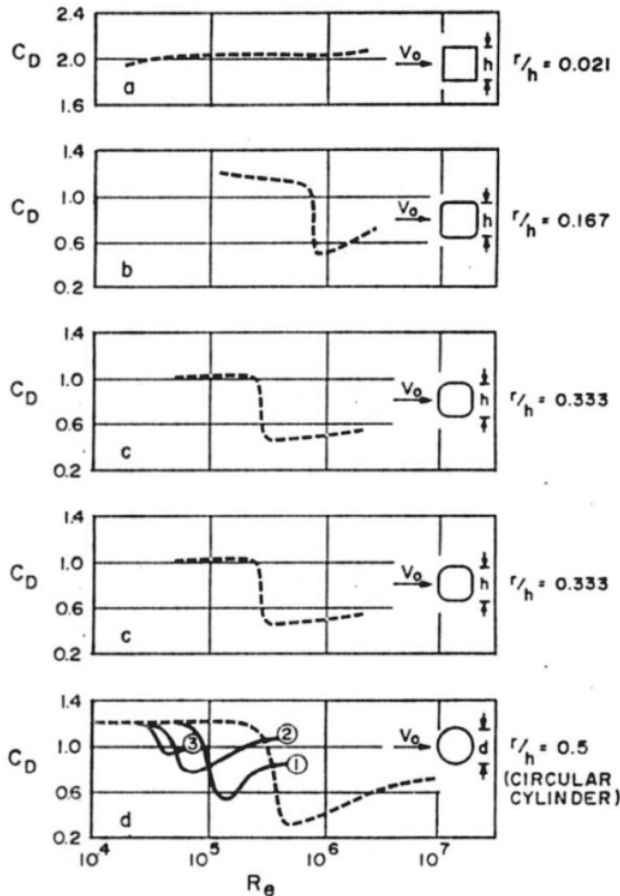
Influence of the Reynolds number variation on the drag coefficient according to the cross-sectional shape. The numbers 1, 2 and 3 in the last figure represent different (and increasing) roughnesses of the circular section surface and have similar effect to a variation of the turbulence in the incident flow (Scruton